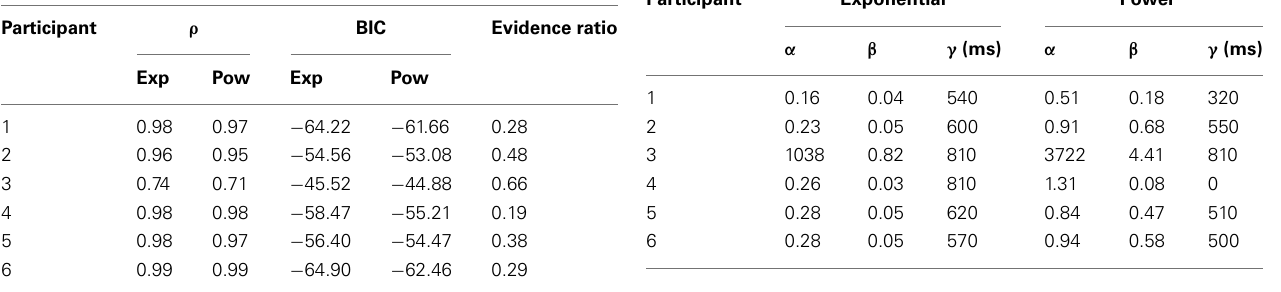
Table 2 | Correlation coefficient ( ρ ), BIC values, and evidence ratios (Wagenmakers and Farrell, 2004) for the three-parameter power function and the exponential function for each participant.